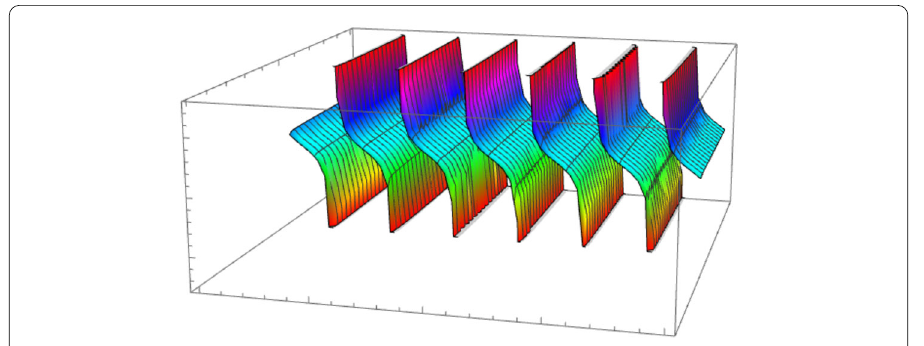
Figure 13 Solitonic solution of u 19 ( η ) for α = 0.25, a 1 = 1, b 1 = 1, V = 12, k = 5